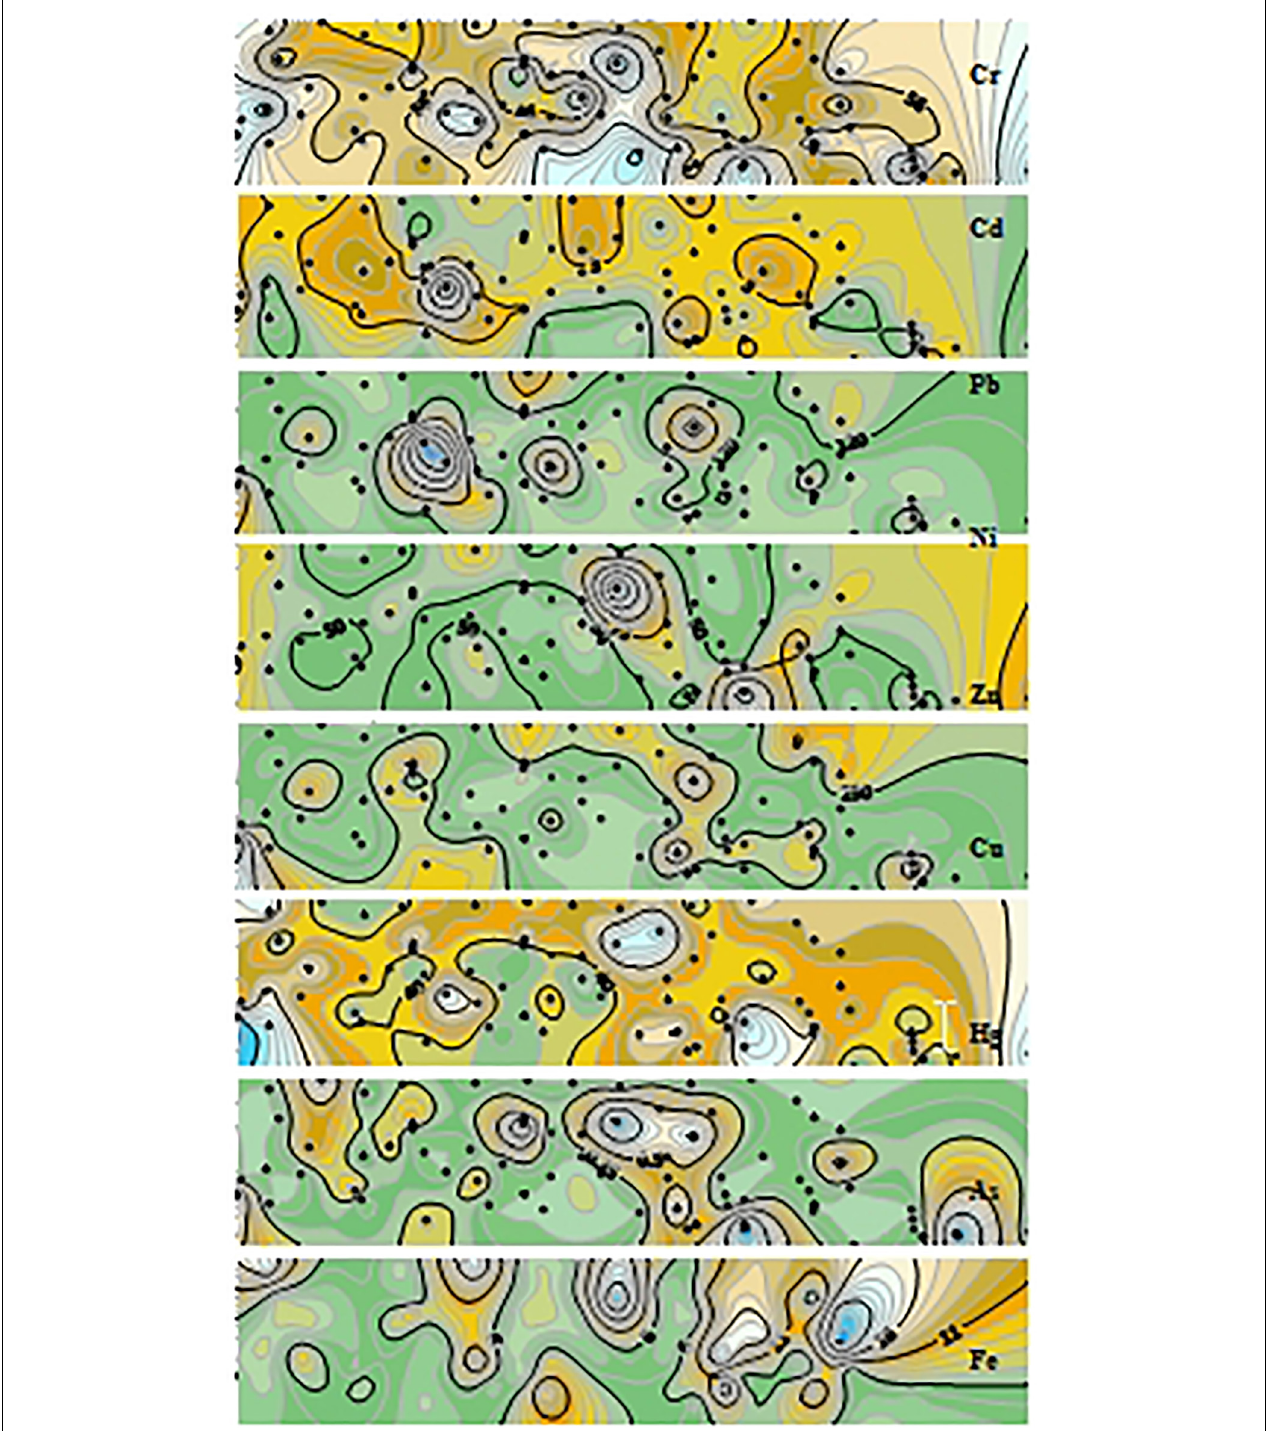
FIGURE 2 | Spatial distribution of Cr, Cd, Pb, Ni, Zn, Cu, As, and Hg, in soil across the study area.